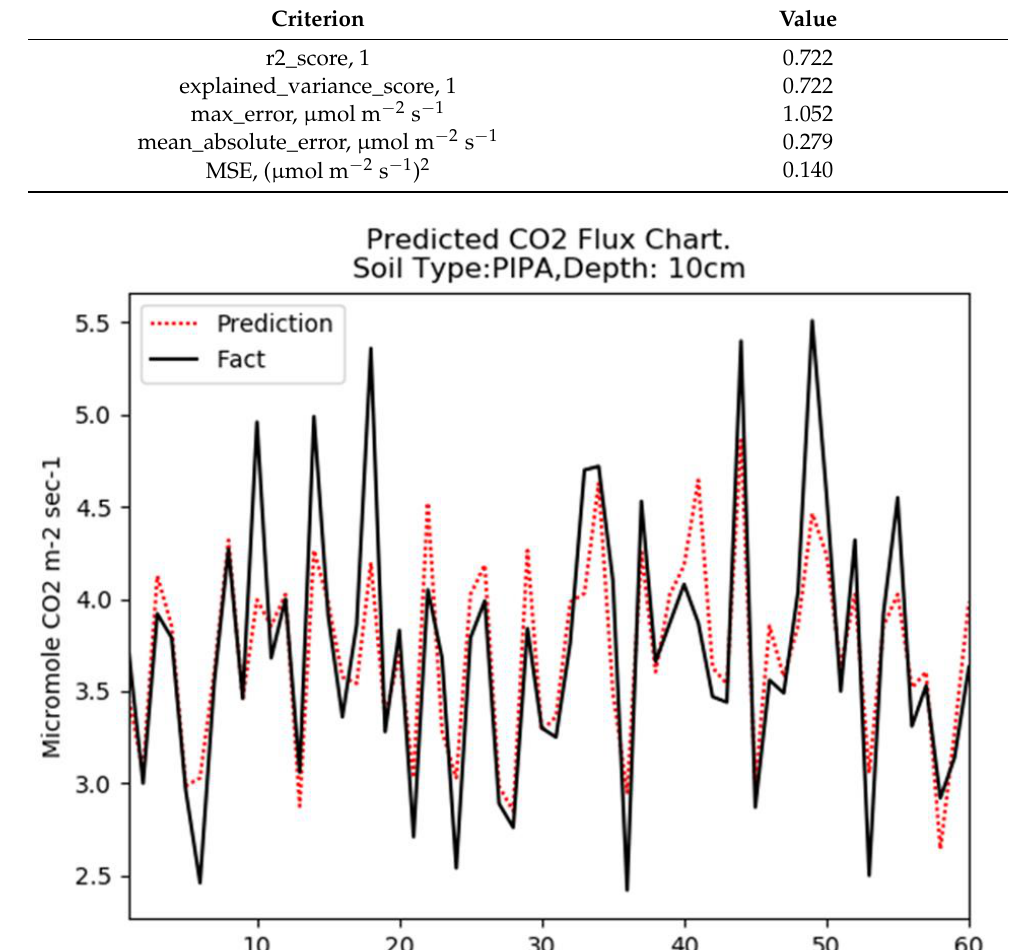
Table 1. The results of experiment 1.